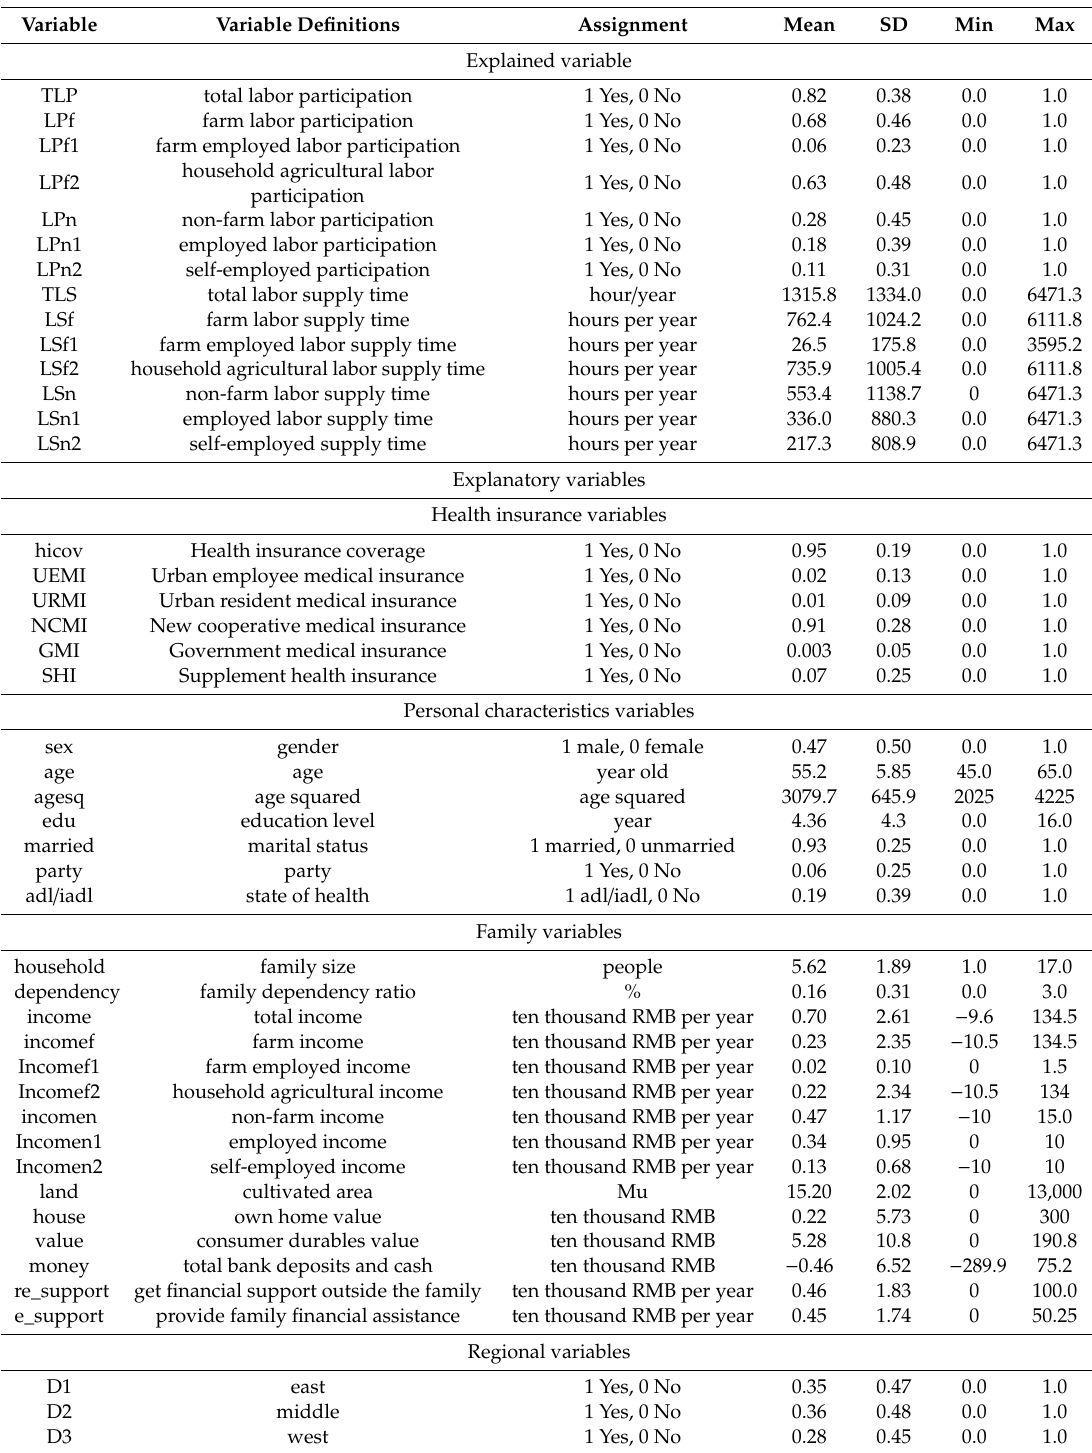
Table 1. Variable definition and descriptive